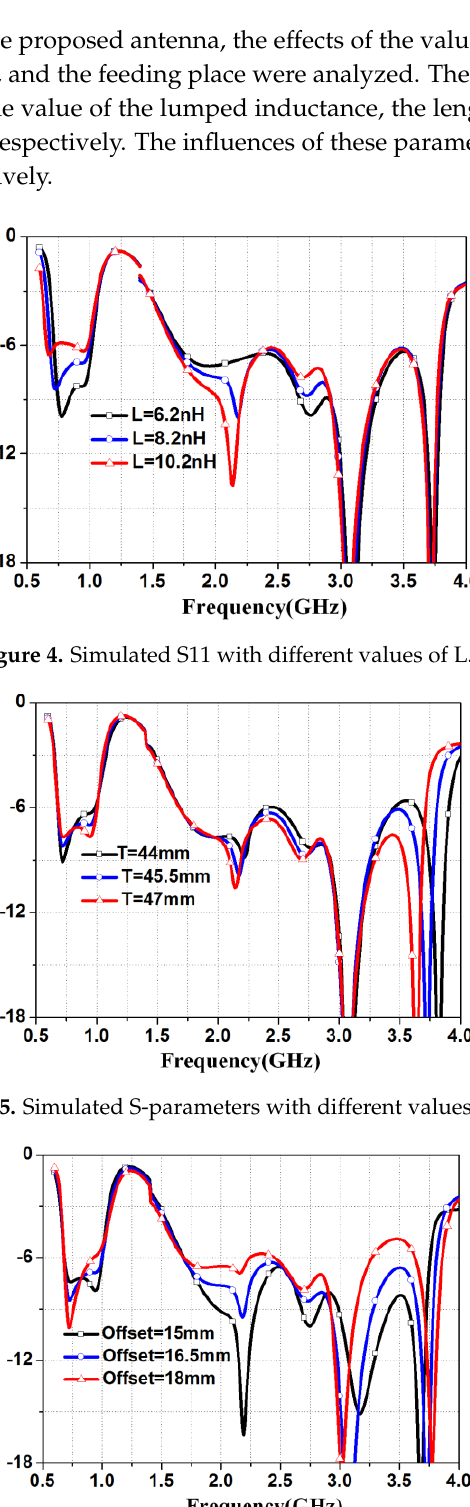
Figure 3. The simulated current distributions of the proposed antenna.